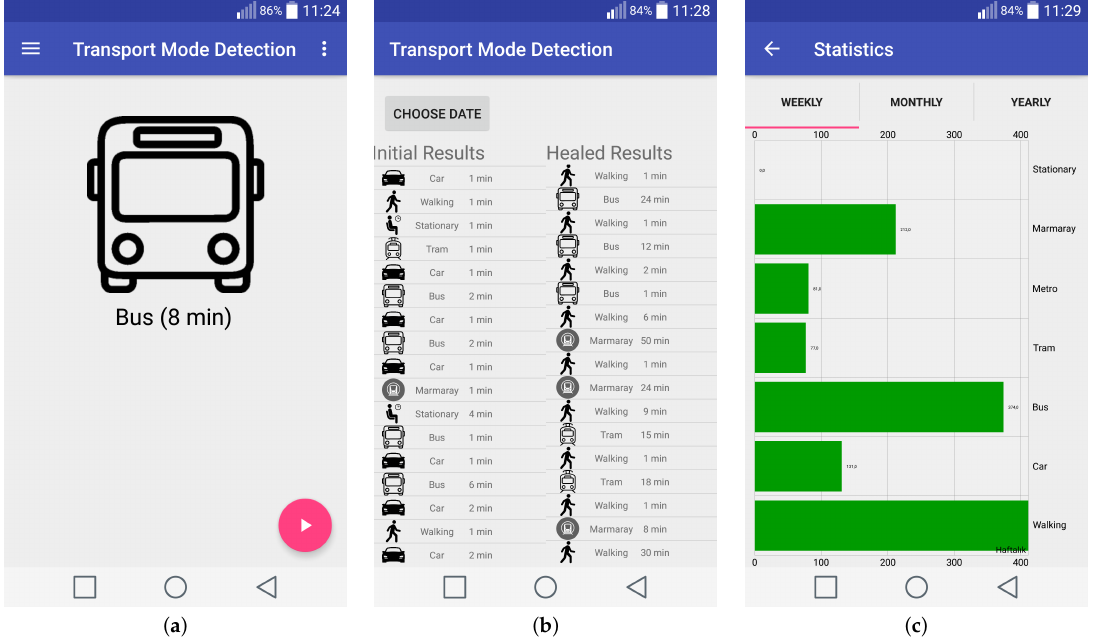
Figure 10. User interface of mobile Transport Mode Detection application. ( a ) Transport Mode Detection Screen; ( b ) results of Initial Transport Mode Detection and Healing algorithm for a given date; ( c ) Statistics of user